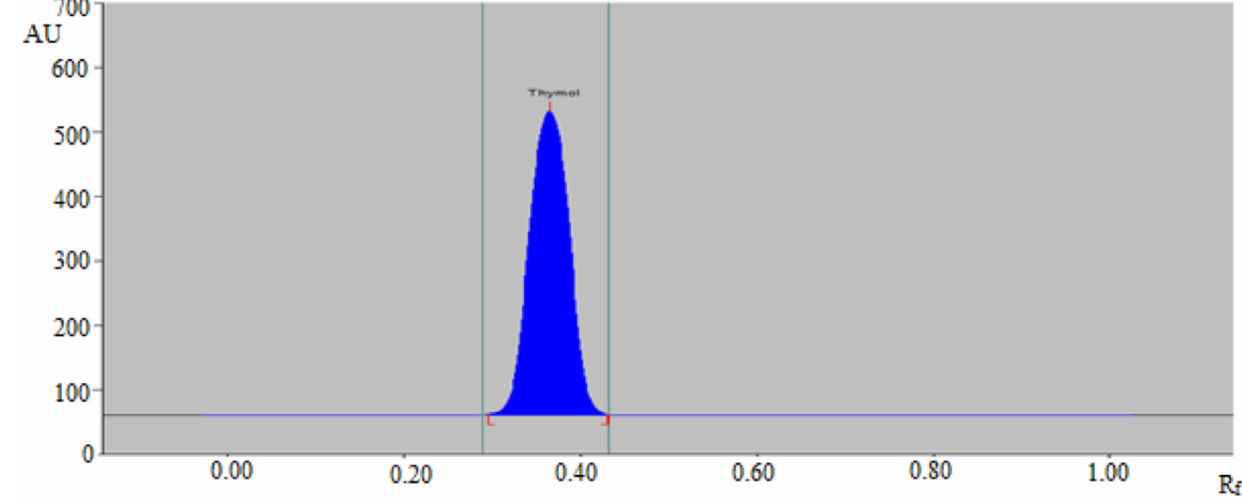
Figure 2. Normal-phase HPTLC densitogram of 500 ng/band concentration of standard thymol for the greener normal-phase HPTLC approach.